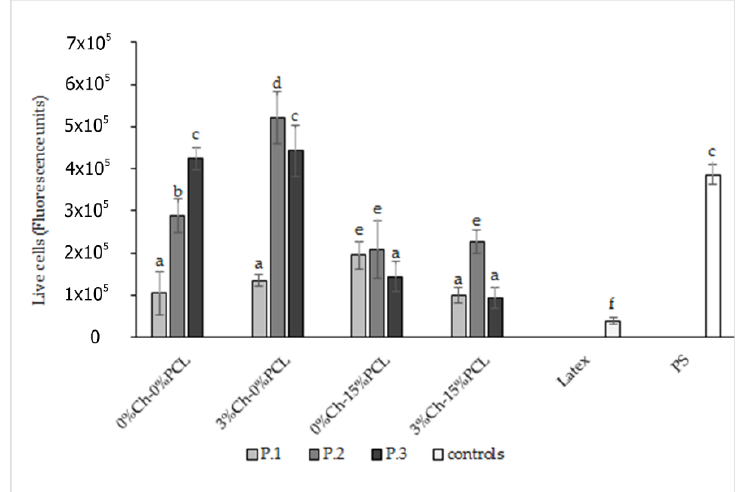
Figure 13. Fluorescence unit results of the in vitro cell viability test after 48 h with the live/dead kit. Polystyrene (PS) positive control; Latex negative control. The data are expressed as the mean ± SD (n = 3). Bars with different letters (a–f) indicate significant differences ( p < 0.05) between polyols.